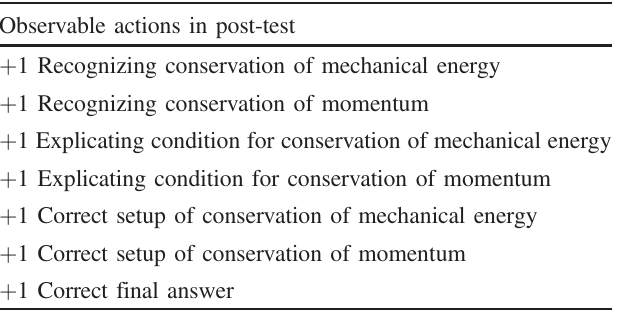
TABLE VII. Scoring rubric for the problem-solving post-test. Observable actions in post-test